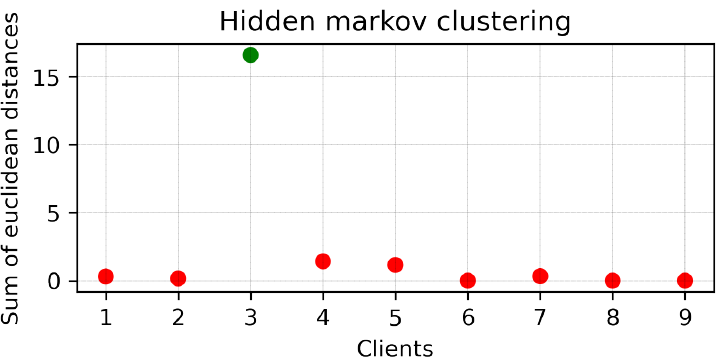
Figure 10. HMM clustering in round 2. Here, red and green colours are used for different clusters.